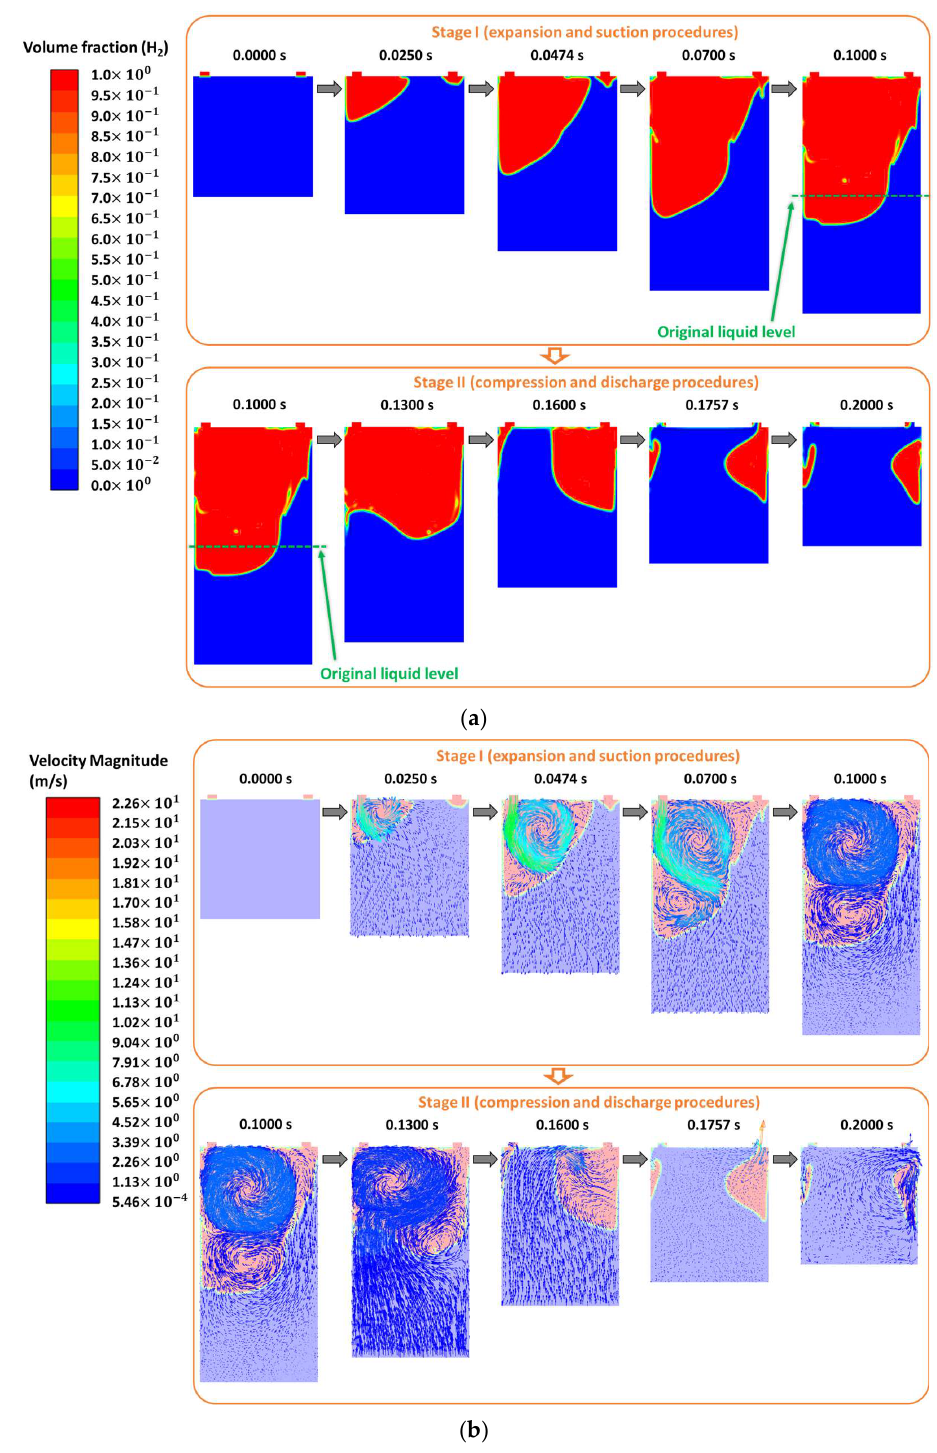
Figure 8. Results of the ( a ) volume fraction distribution and ( b ) velocity distribution (density of the ionic liquid: 1600 kg/m 3 ).